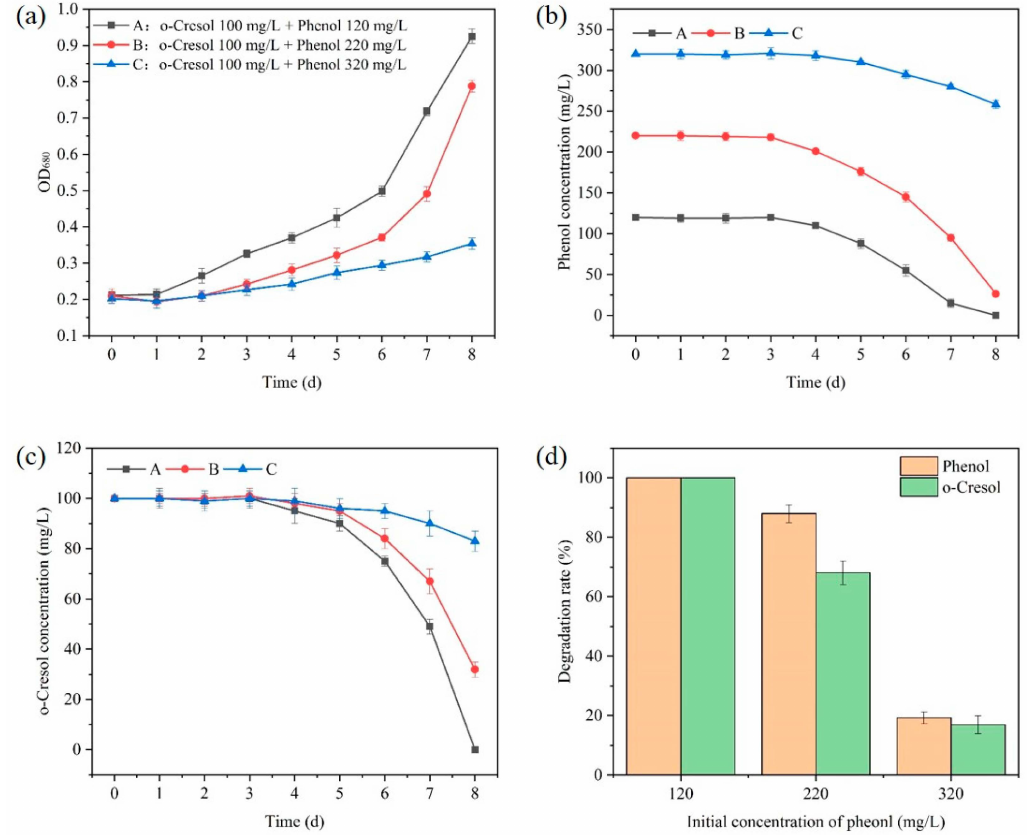
Figure 5. Co-degradation of phenol and o-cresol. ( a ) The growth curve in the co-degrading system; ( b ) degradation curve of phenol; ( c ) degradation curve of o-cresol; and ( d ) degradation rate of phenol and